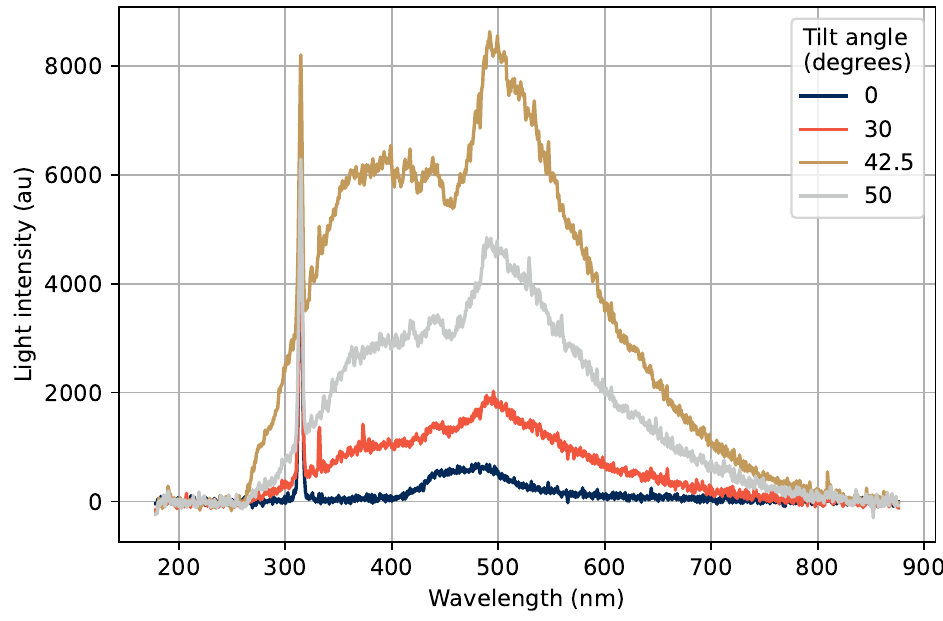
Figure 8. Emission spectra at different tilt angles, with the sharp emission peak of Gd 3 + at 314 nm, as well as a wide Cherenkov emission spectrum with a maximum intensity at 42.5 ◦